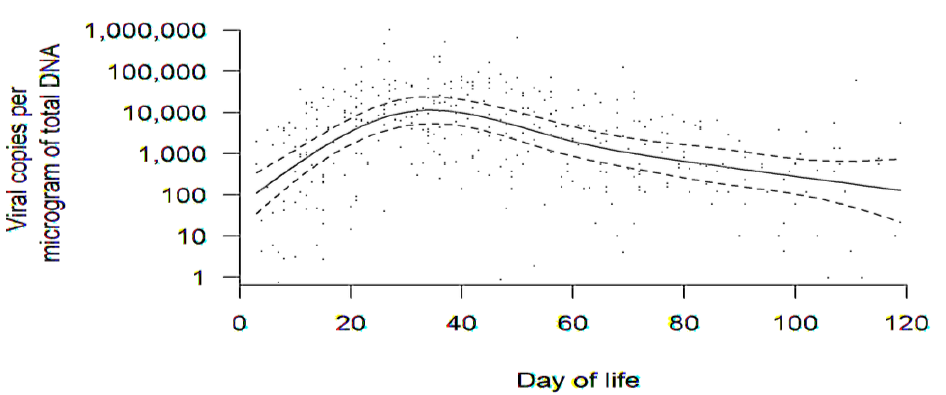
Figure 2. Aggregate trend in DNAlactia (viral load, copies/μg total DNA) over time (through day of life 120) for all available samples for the 65 mothers with PCR-positive breast milk. Raw data for viral load from breast milk samples were used to calculate a group average at various times, accounting for how individual averages changed over time. Data in this figure were comprised of PCR results from 380 discrete breast milk samples. The dotted lines are 95% confidence bands for the mean